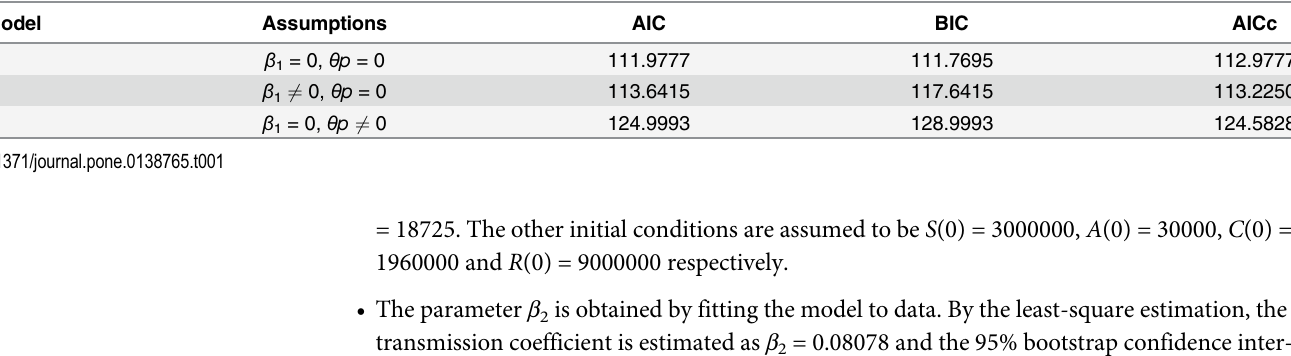
Table 1. Model selection for HBV data. Submodel Assumptions